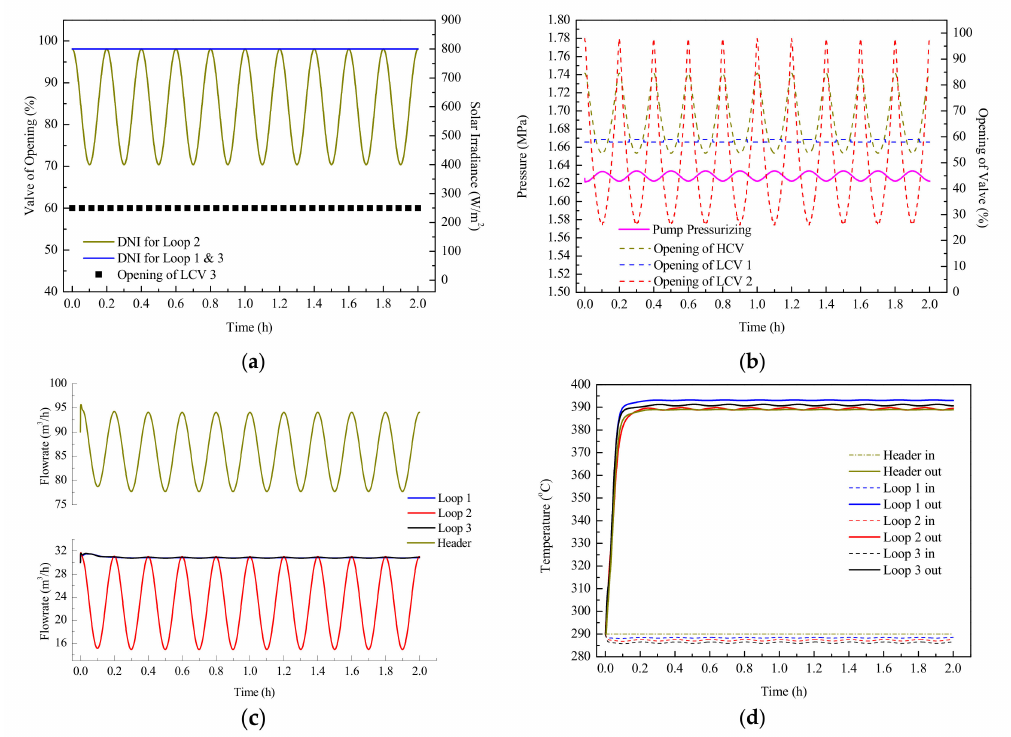
Figure 19. LCV control for ( a ) Initial parameters and DNI disturbance; ( b ) Results of HCV opening, LCV opening, and pump pressurizing; ( c ) Inlet flow rate results of the header and three loops; ( d ) Inlet and outlet temperature results of the header and three